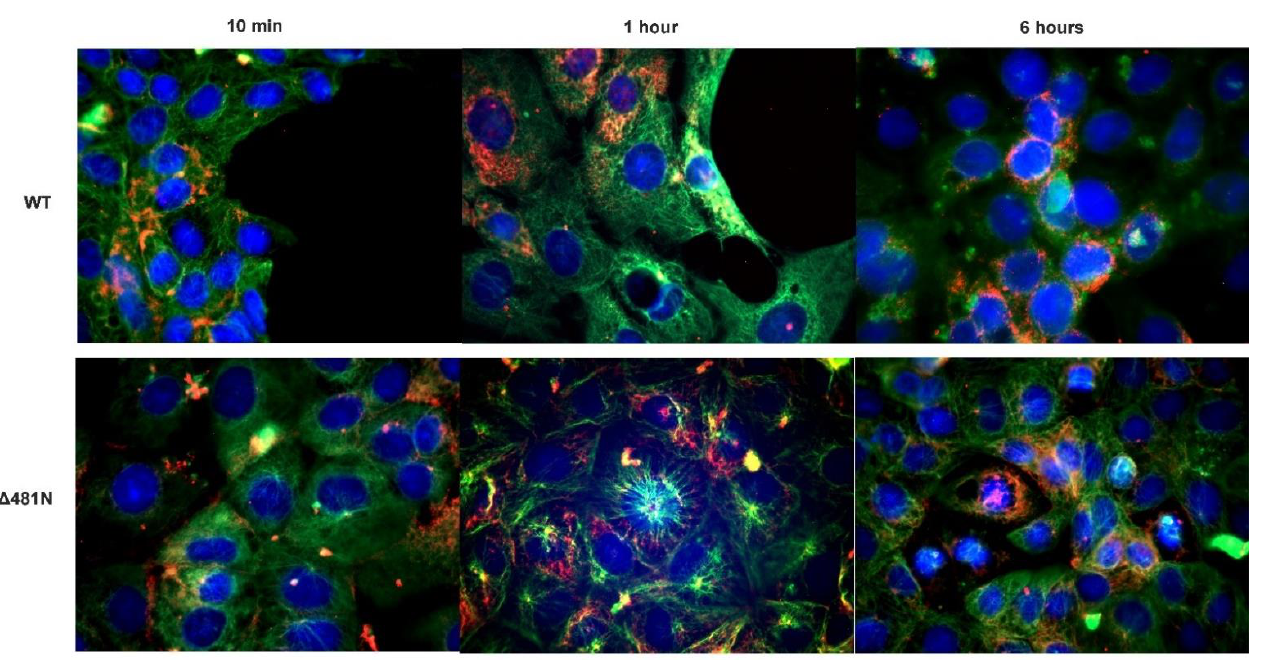
Figure 7. Intracellular transport assay of WT and ∆ 481N mutant virus. Vero cells were infected with WT and ∆ 481N mutant virus and examined for transport of viral capsids (red) on the tubulin network (green) at 10 min, 1 h and 6 h after adsorption. Rabbit α -tubulin (Abcam, Inc., Cambridge, MA, USA) (1:100) and mouse anti-HSV-1 ICP5 (Santa Cruz Biotechnology Dallas, TX, USA) (1:100) were used to visualize viral capsid transport. Secondary antibodies used were anti-rabbit Alexa Fluor TM 488 anti-mouse Alexa Fluor TM 647 (1:1000), respectively. Nuclei (blue) were stained using DAPI (49,6-diamidino-2-phenylindole).